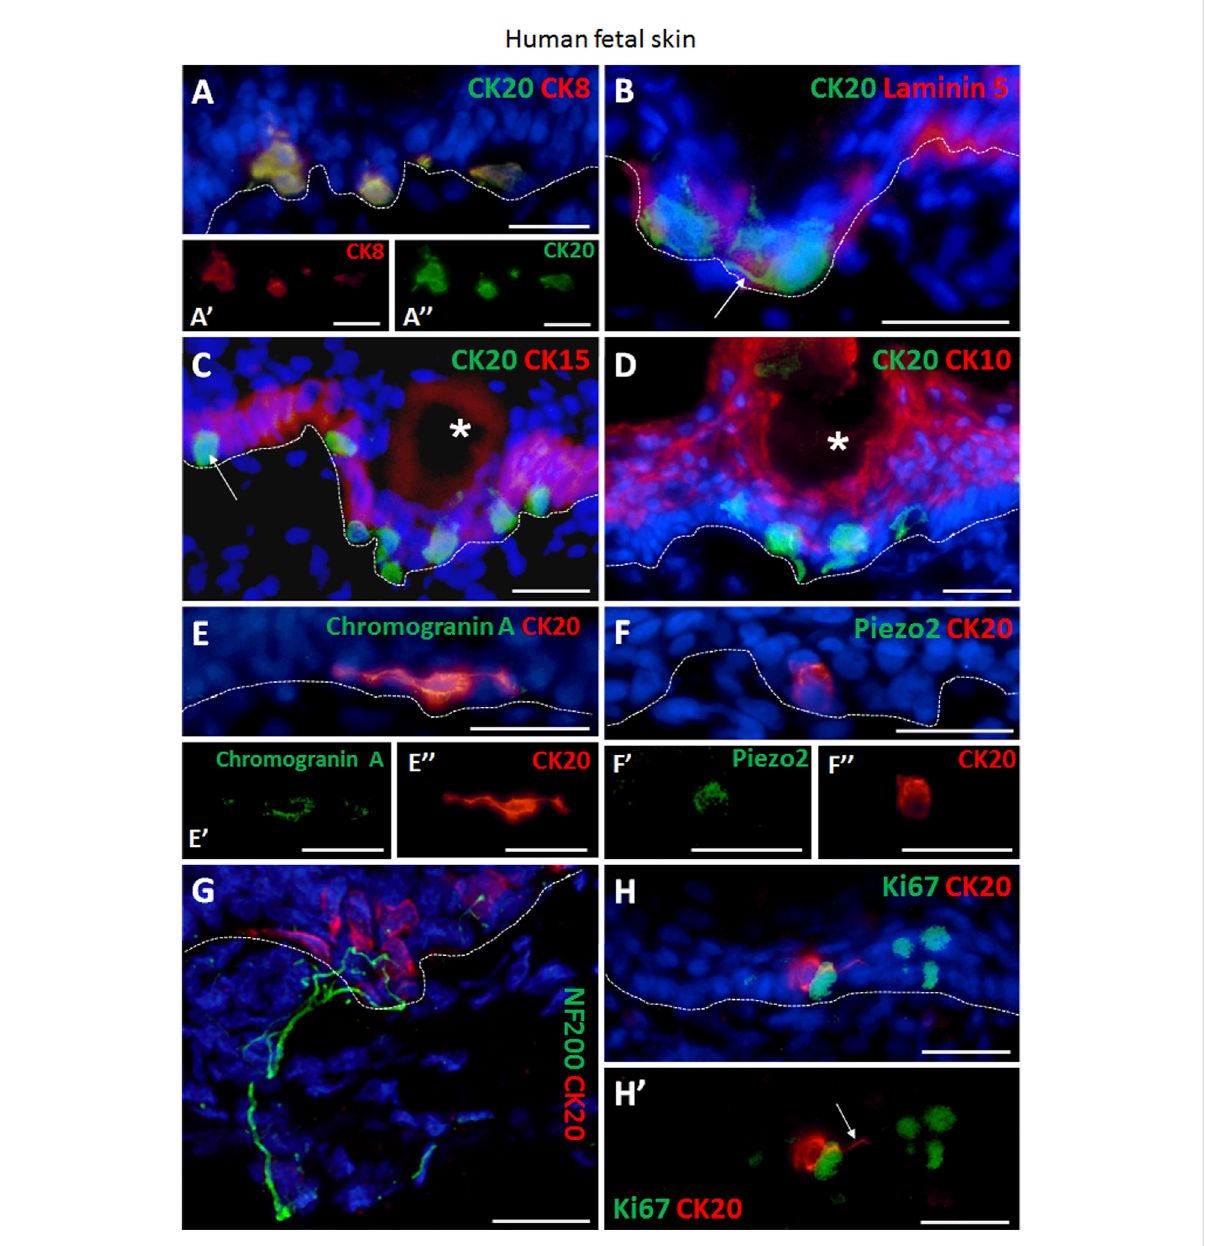
FIGURE 1 Immuno fl uorescencestainingofhumanfetalbackskin. (A,A 9 ,A 0 ) CK20andCK8doublepositiveMerkelcells( A ,CK20green,CK8red). A 9 and A 0 display single staining of CK8 (red) or CK20 (green) of Merkel cells shown in (A) . (B) CK20-positive (green) Merkel cells and basement membrane component Laminin 5 (red). White arrow depicts dendritic protrusion of a non-oval Merkel cell. (C) CK20-positive (green) Merkel cells and CK15- positive (red) basal layer keratinocytes. White arrow indicate a non-dendritic oval Merkel cell in interfollicular epidermis. White asterisk marks a hair follicle. (D) Merkel cells (CK20, green) and CK10-positive (red) suprabasal layer keratinocytes. White asterisk denotes a hair follicle. (E,E 9 ,E 0 ) Expression of neuroendocrinemarker chromogranin A (green) inCK20-positive (red) Merkel cell. E 9 and E 0 displaysinglestaining of chromogranin A (green) or CK20 (red) of Merkel cell shown in (E). (F,F 9 ,F 0 ) Presence of Piezo-type mechanosensitive ion channel component 2 (Piezo2, green) in CK20-positive (red) Merkel cell. F 9 and F 0 depict single staining of Piezo2 (green) or CK20 (red) of Merkel cell shown in (F) . (G) Neuro fi lament 200 (NF200, green) nerve endings projecting to Merkel cells (CK20, red). (H,H 9 ) Ki67 (green) as marker for proliferating cells. CK20-positive (red) Merkel cells are Ki67-negative. (H 9 ) displays Ki67 (green) and CK20 (red) double staining without cell nuclei Hoechst dye. White arrow denotes dendritic protrusion of Merkel cell. Dashed white lines indicate locations of dermal-epidermal junctions. Hoechst 33342 (blue) was used to counterstain nuclei. Scale bars: 25